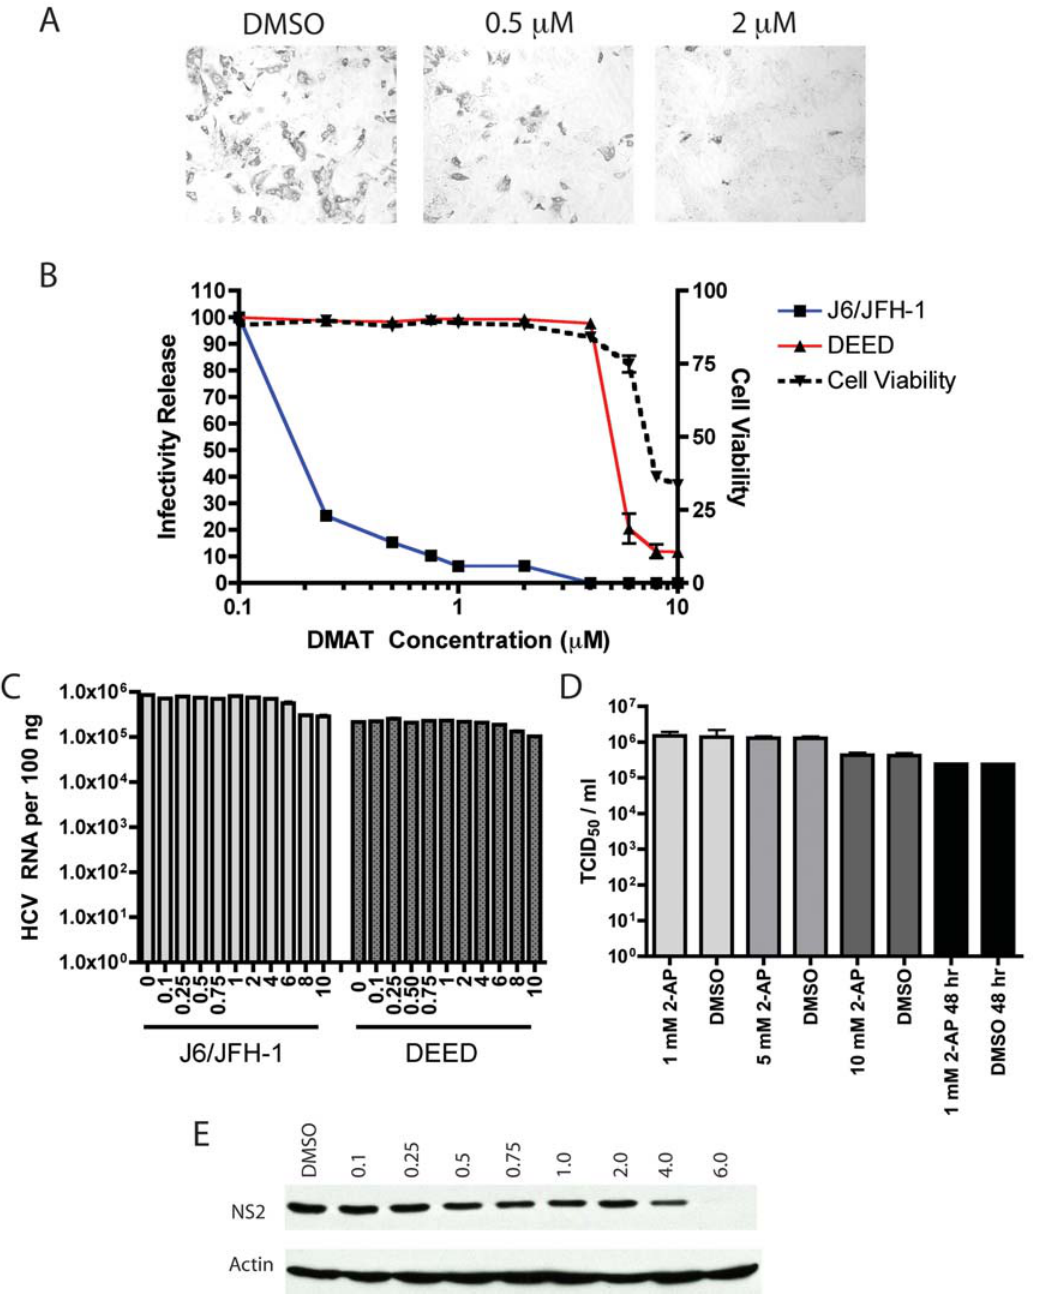
Figure 4. The casein kinase II inhibitor DMAT disrupts the production of infectious virus. A). IHC infectivity assay showing cells 48 hours post infection stained for NS5A expression. Individual images correspond to cells treated with DMSO, 0.5 m M DMAT in DMSO, and 2 m M DMAT 4 hours after electroporation. B). Infectivity release of J6/JFH-1 and J6/JFH-1 DEED 48 hours post electroporation versus dose of DMAT added to cells. Values shown are percent infectivity release of DMSO treated cells receiving identical viral RNAs. Cell viability is percent viable cells of a DMSO only treated control cells as measured by an ATP based cell viability assay. C). HCV RNA replication 48 hours post indicated concentration of DMAT treatment for J6/JFH-1 (light gray bars) and J6/JFH-1 DEED (dark gray bars) RNA electroporations. Bars designated zero are DMSO only treated. D). Treatment of cells with an unrelated kinase inhibitor, 2-aminopurine (2-AP), does not affect infectious virus release. Cells were treated with 2-AP at the indicated concentration or a DMSO control for 1 hour prior to infection. Virus output was then titered 48 hours post infection. In another experiment, 2-AP, was left in the culture medium at 1 mM for the 48 hour course of the experiment (black bars). E). Effect of CKII inhibition with DMAT on NS2 stability. Indicated doses of DMAT were added to cells electroporated with JC1 HCV RNA for a period of 48 hours. Following this treatment, cells were lysed and Western blots for NS2 (top row) and b -actin (bottom row) were performed to look for differences in NS2 stability.